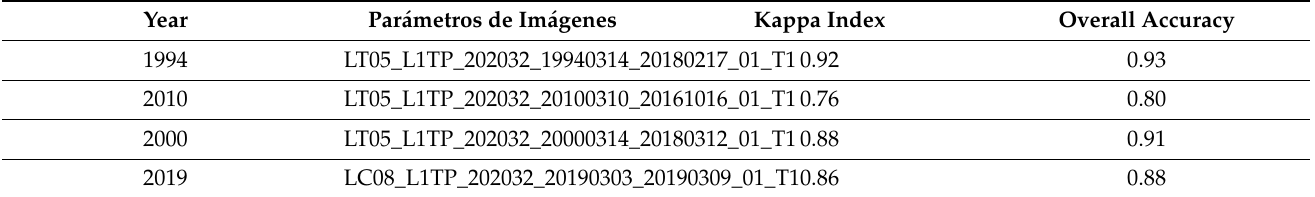
Table 4. Kappa index and overall accuracy for supervised classification (material